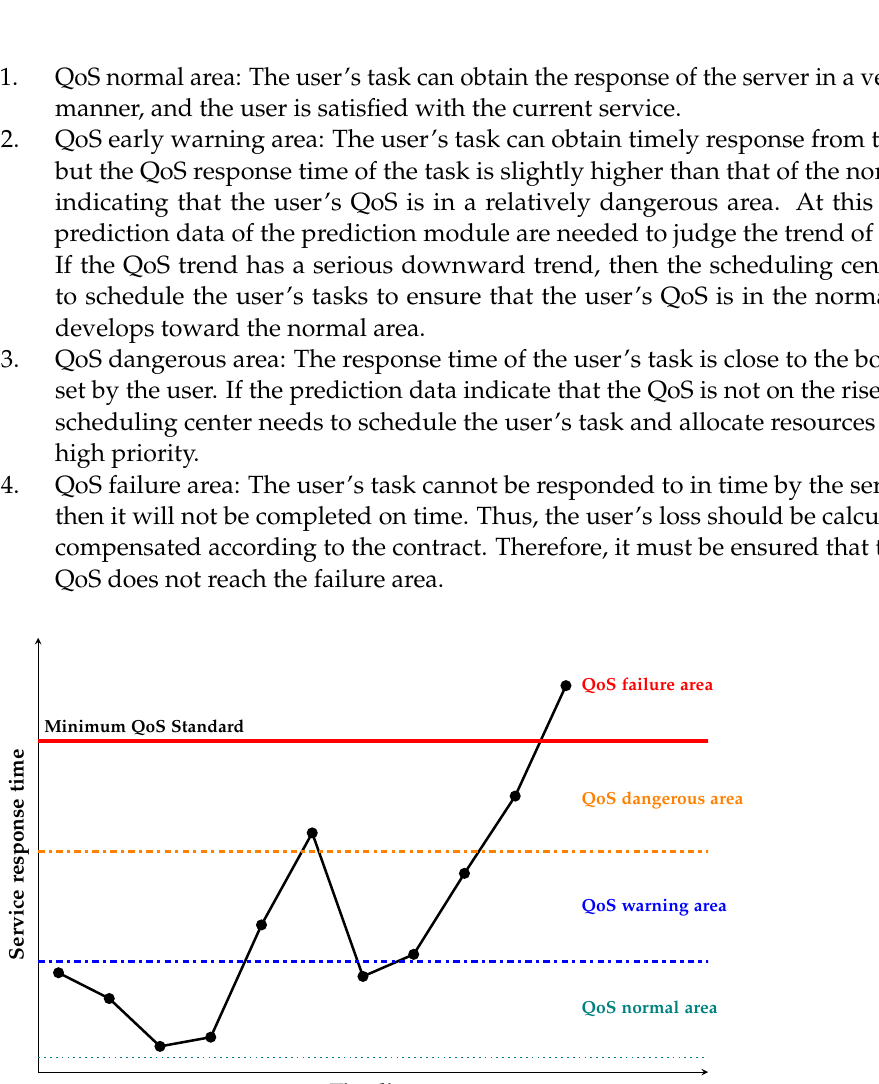
Figure 3. User QoS state